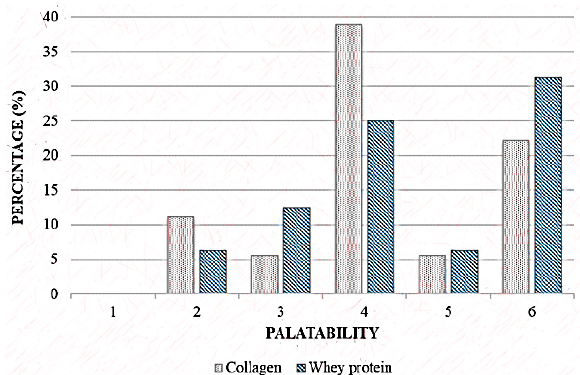
Figure 2. Palatability scale of Collagen and Whey protein group. 1: extremely unpalatable; 2: moderately unpalatable; 3: neither unpalatable nor palatable; 4: slightly palatable; 5: moderately palatable; 6: extremely palatable. Wilcoxon´s test, p = 0.61.